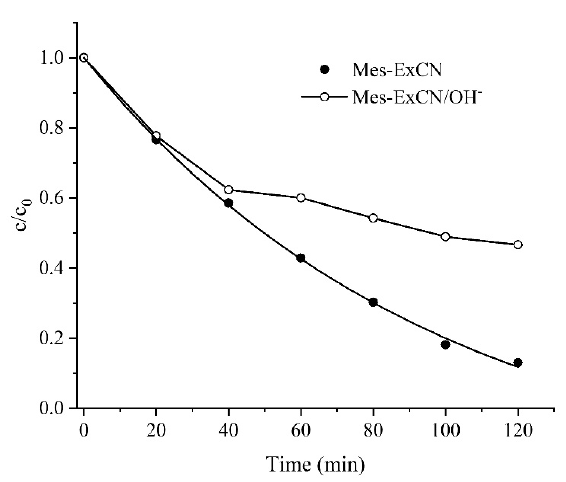
Figure 10. Photocatalytic decomposition of AO7 in aqueous dispersions of original MeS-ExCN and MeS-ExCN exchanged with hydroxide (Mes-ExCN/OH − ).